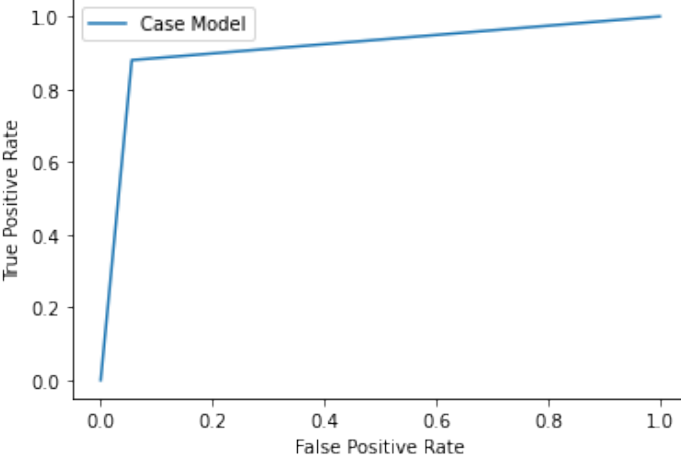
Figure 12. ROC Curve of Case